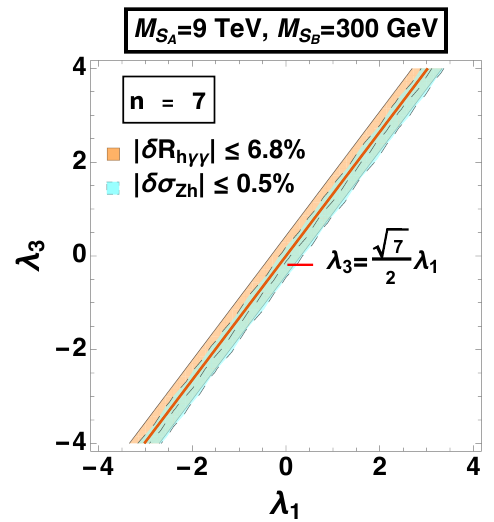
Figure 11. Contours by | δσ Zh | ≤ 0 . 5% (cyan band outlined with dashed lines) and | δR hγγ | ≤ 6 . 8% (orange band outlined with solid lines) compared to the line (red solid) for λ with fixed values of M = 9 TeV and M = 300 GeV S A S B